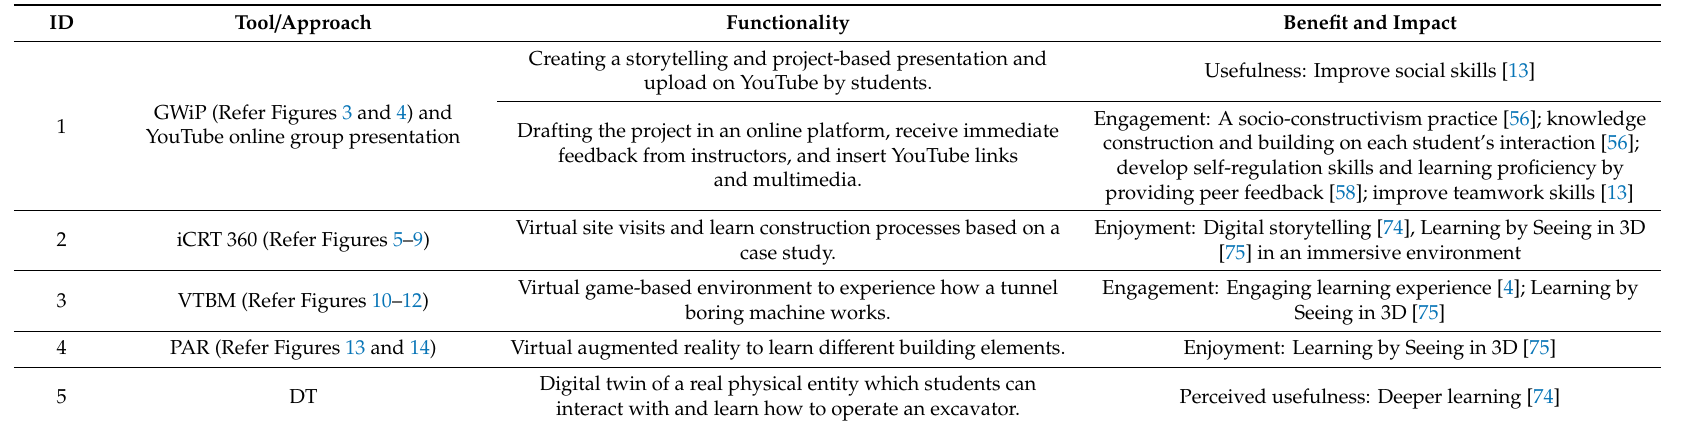
Table 8. Summary of functionalities and benefits of online teaching tools based on the instructor observation and the